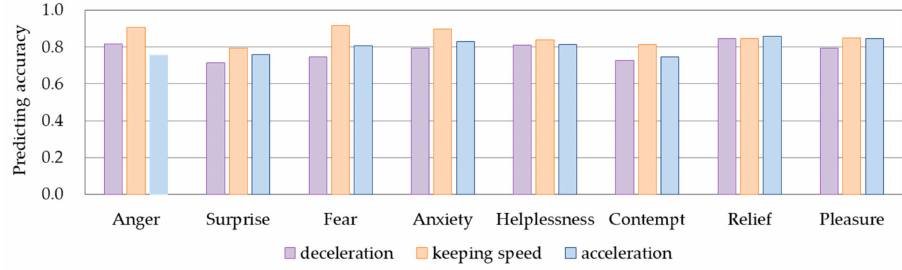
Figure 14. Accuracy in predicting driving intentions of HMMs for di ff erent emotions.